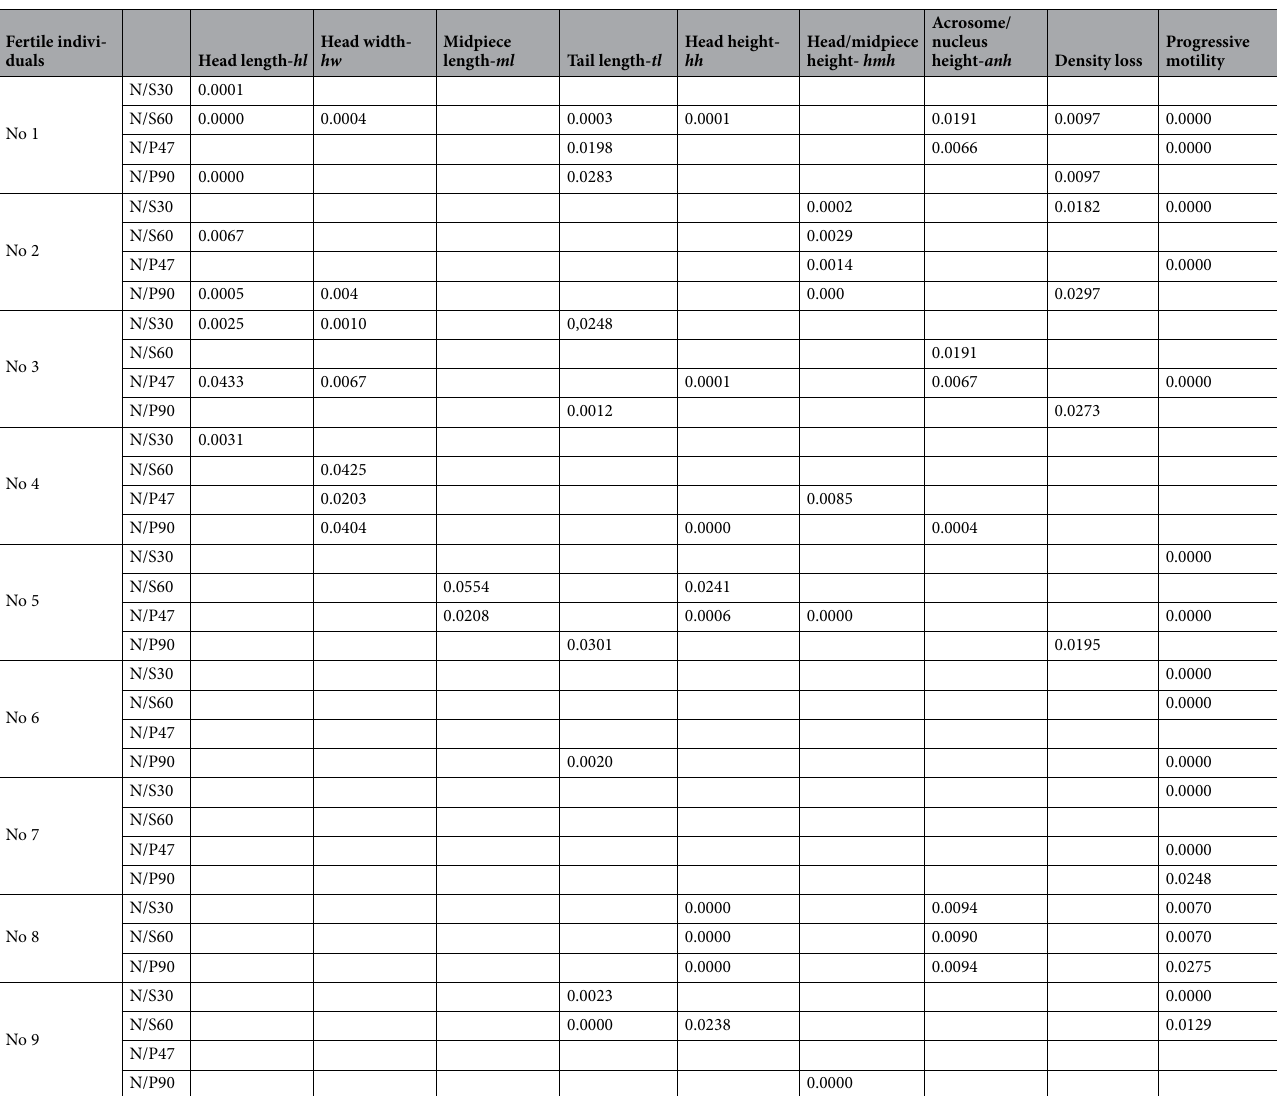
Table 3. Statistical differences of parameters between “native” and separated semen samples by Percoll gradient and “swim-up” technique. Results are expressed as P -value using the Kruscal-Wallis test with Holm adjustment for multiple comparisons.